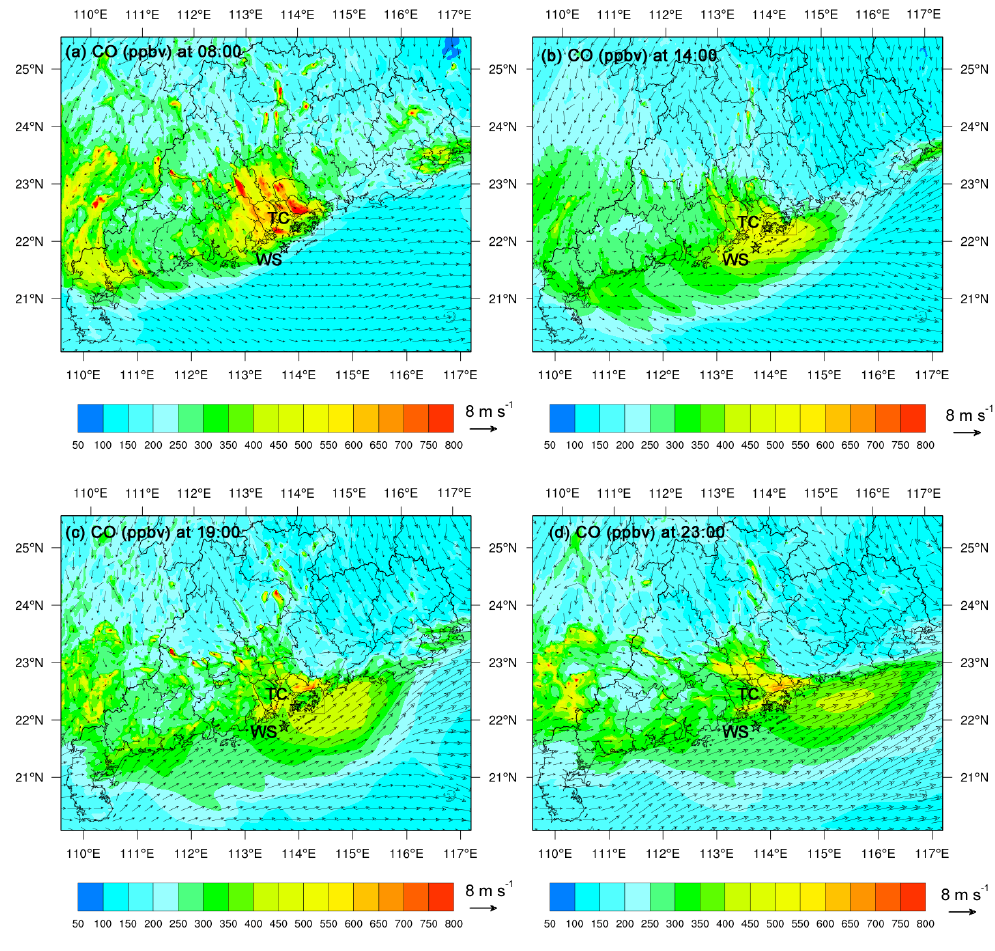
Figure 6. Spatial distribution of CO at 08:00 (a) , 14:00 (b) , 19:00 (c) and 23:00 (d) on 21 August simulated by WRF-CMAQ, taken as an example of the “outflow” interaction pattern. Arrows in the figure represent the surface wind